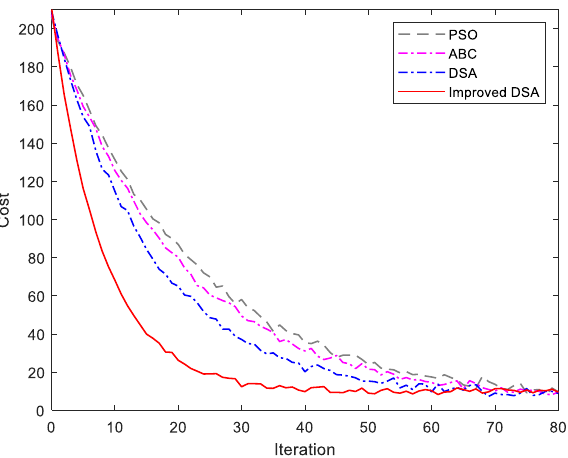
Figure 8. Evaluation of improved DSA algorithm under 10 individuals.